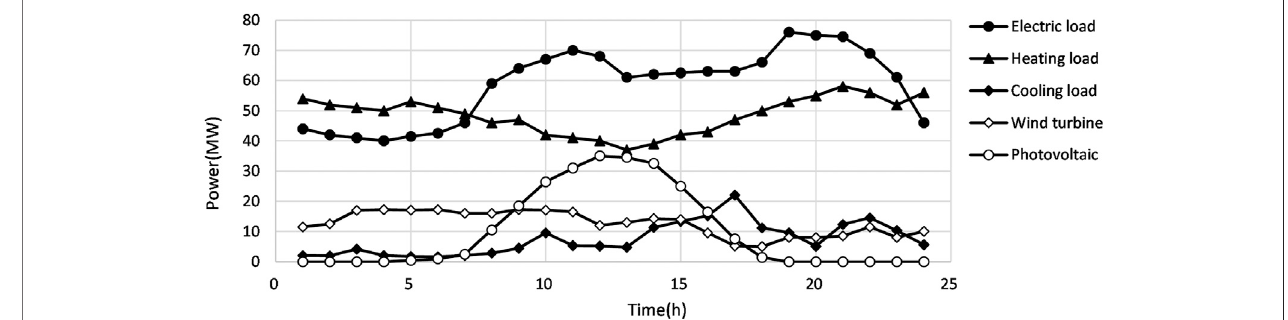
FIGURE 6 | Power, heating and cooling load, and renewable energy curves of a typical day in winter.